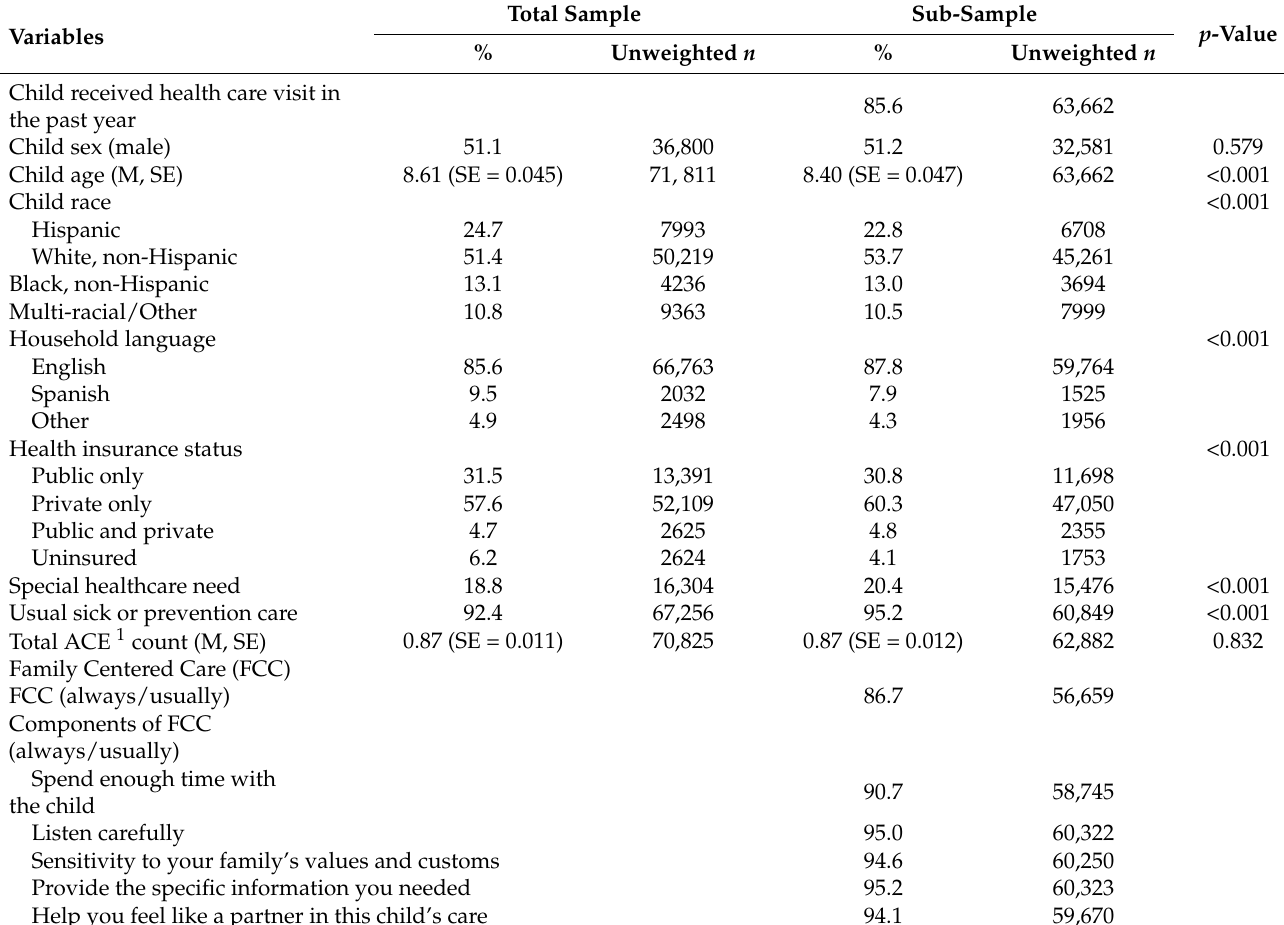
Table 1. Descriptive Statistics for Total Sample (N = 71,811) and Sub-sample of Children